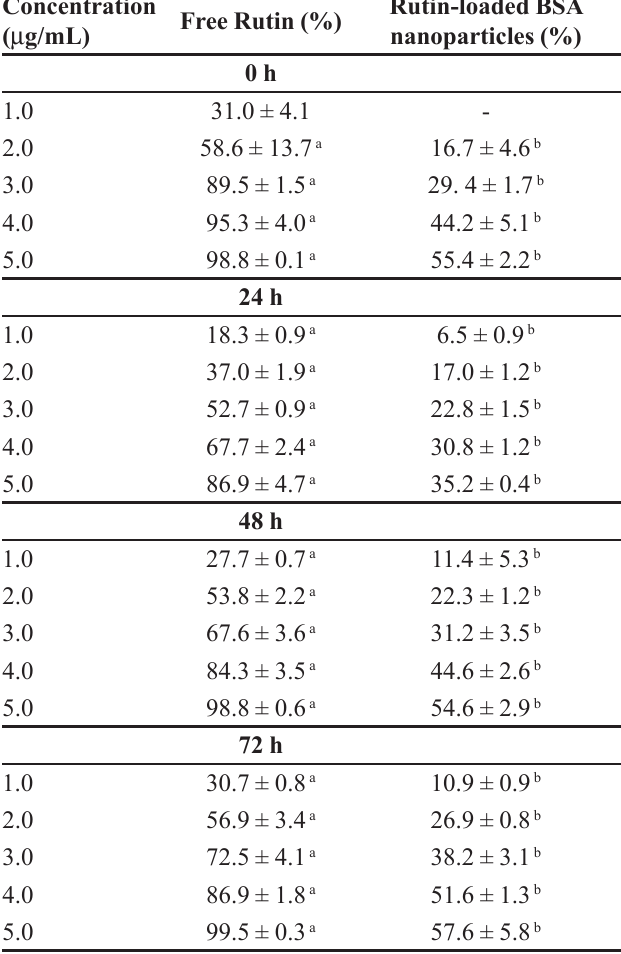
a, b Percentage of inhibition of radical ABTS·+ ± standard deviation per line analyzed. Same letters mean statistical equality and inequality statistics are shown for different letters (Student’s t test and α 0.05) (n=3).